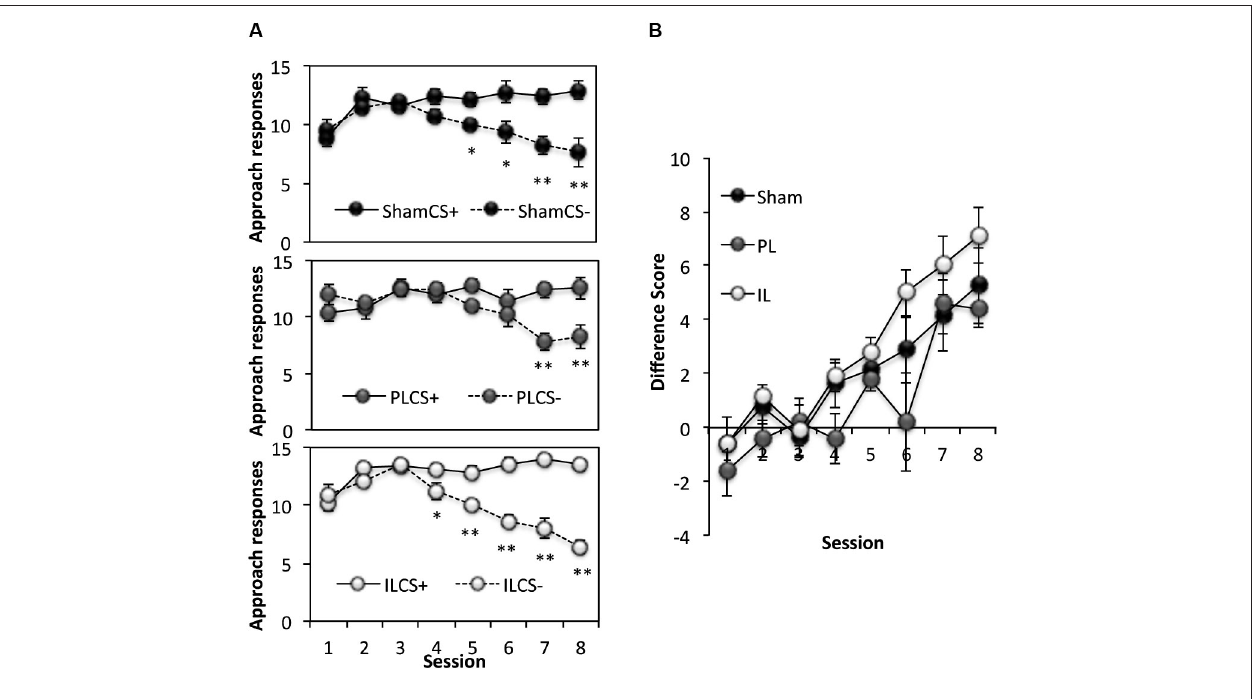
(non-rewarded) in each session. * p < 0.05, ** p < 0.01 compared to approach responses to CS+. (B) The acquisition data expressed as a difference score (number of approaches to CS+ ( − ) number of approaches to CS −